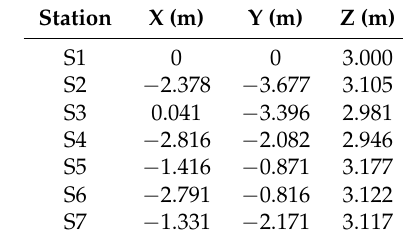
Figure 2. Ground-based navigation system. Table 1. Coordinates of transmitter antennae.